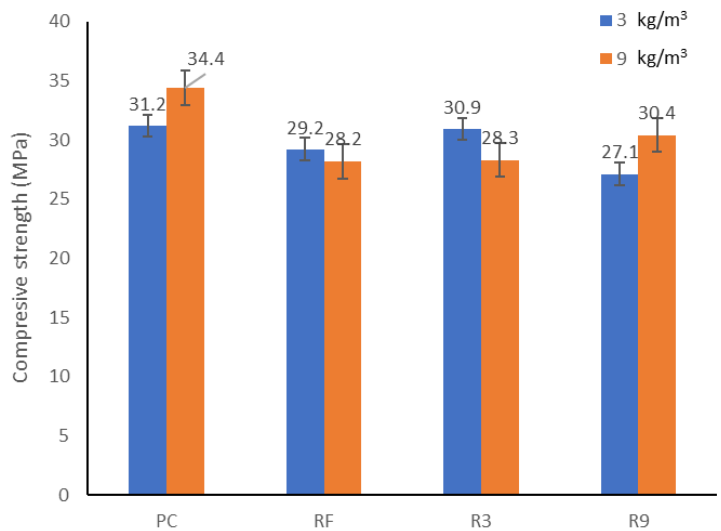
Figure 7. The compressive strength result of tested concrete.